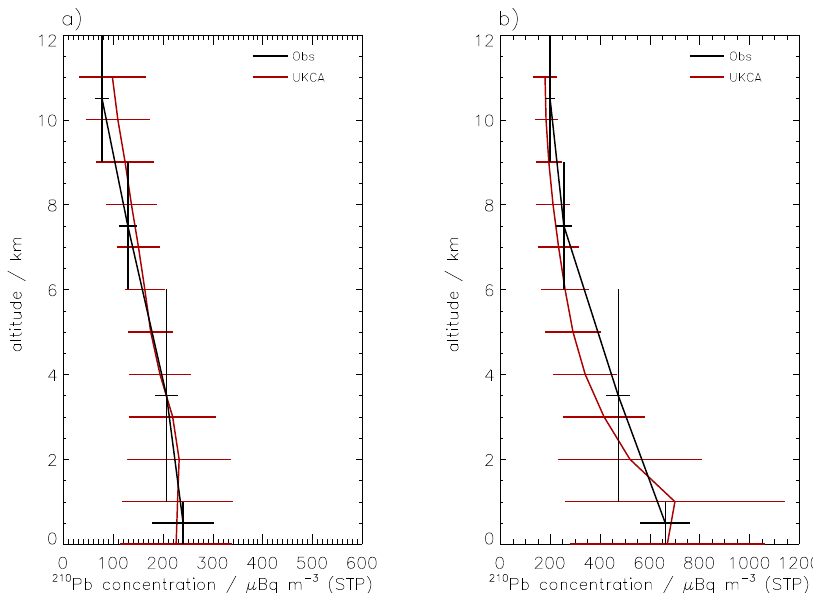
Fig. 9. Comparison between observed vertical profiles of 210 Pb concentrations with modelled concentrations from UKCA (red) over (a) the “remote Pacific” and (b) over “near Asia”. Observations are taken from Dibb et al. (1997).